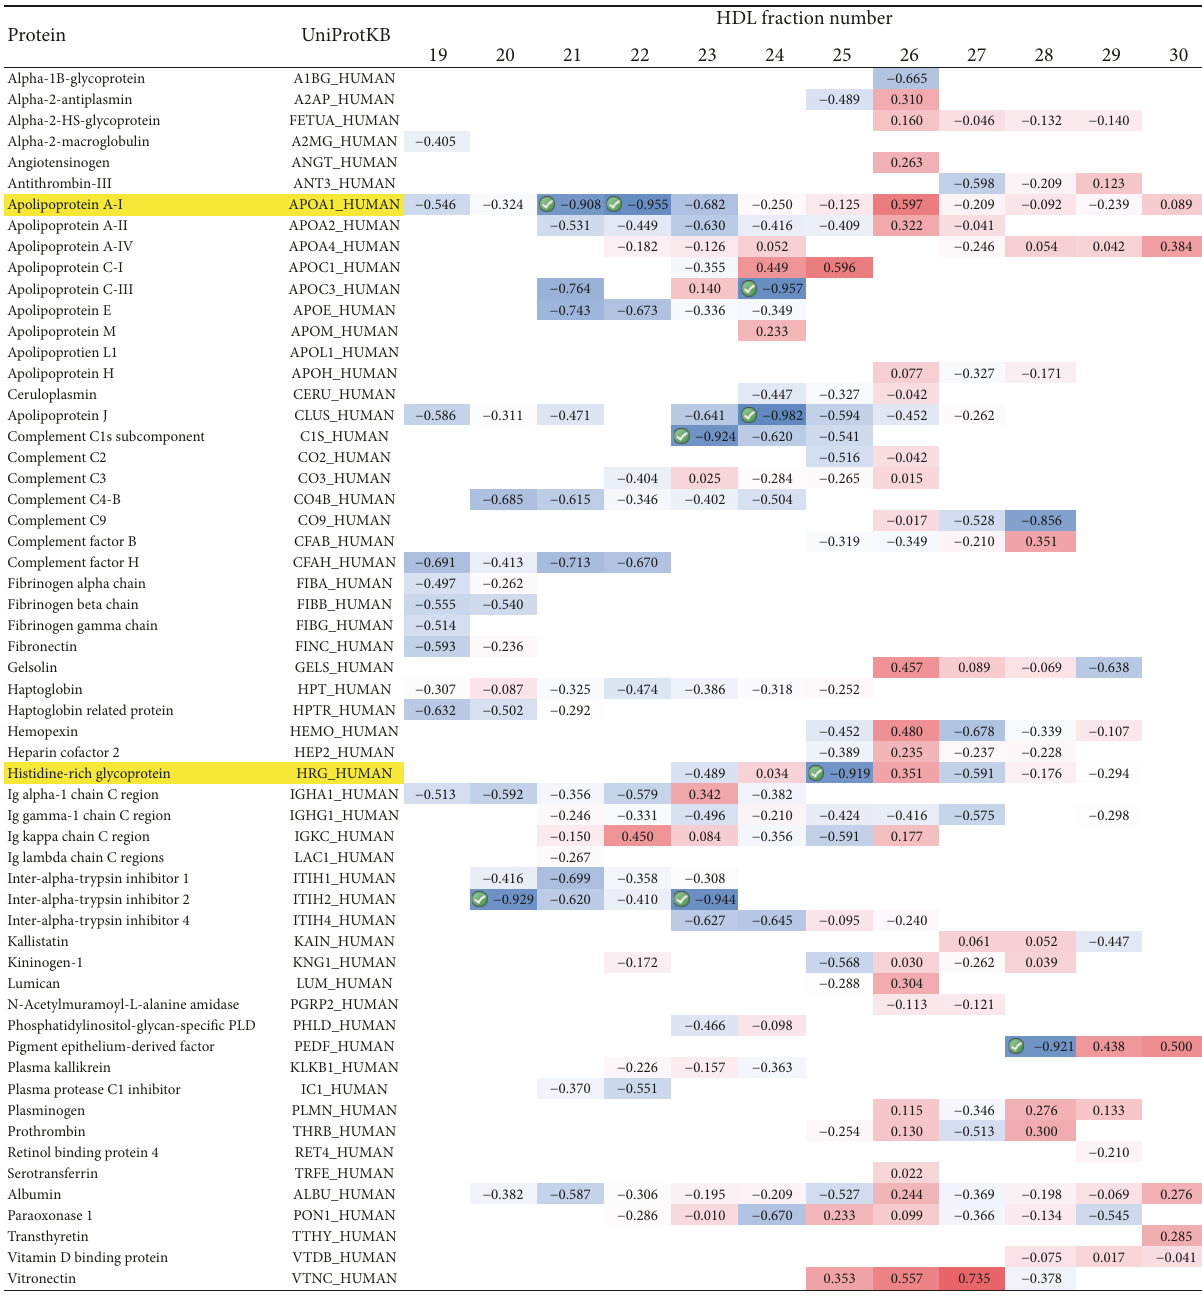
Figure 1: PCCs of peptide counts of individual proteins with PWV for the lean group across HDL fractions. Red, white, and blue are used to mark maximal, medium, and minimum value, respectively. Green checkmark indicates significant correlation. The proteins that also correlate with PWV in the T2D group are highlighted in